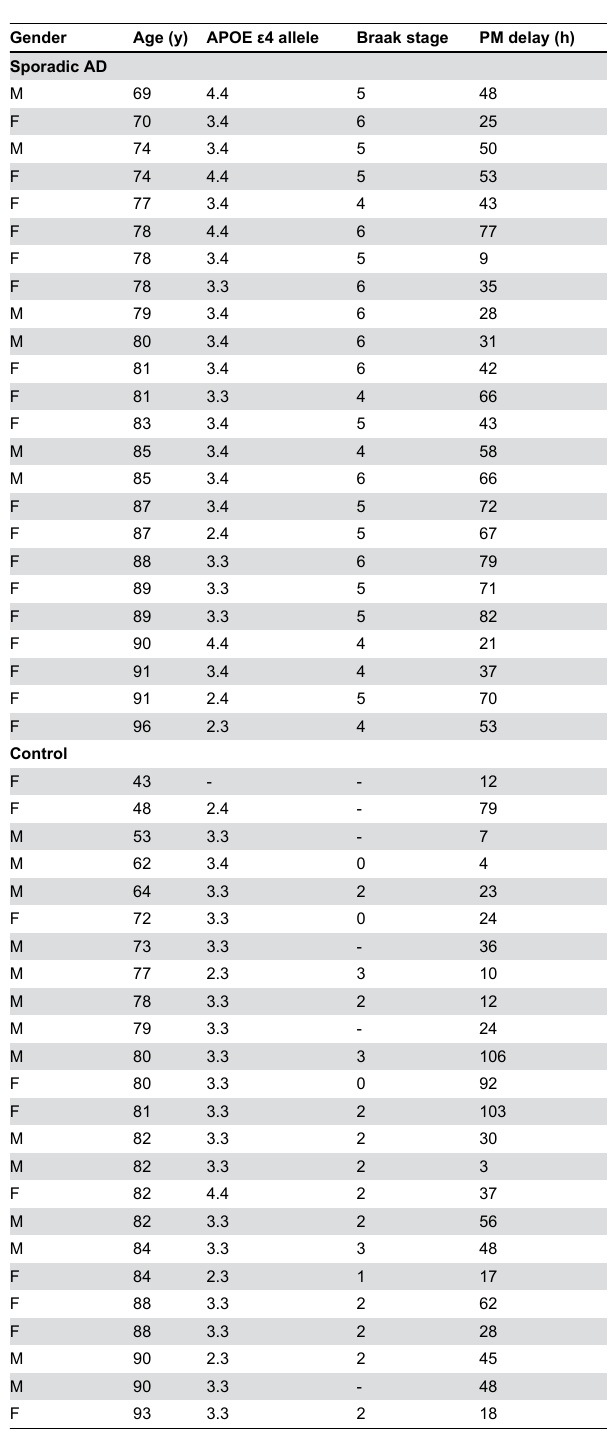
Table 1. Characteristics of the sporadic AD and control cases used in the